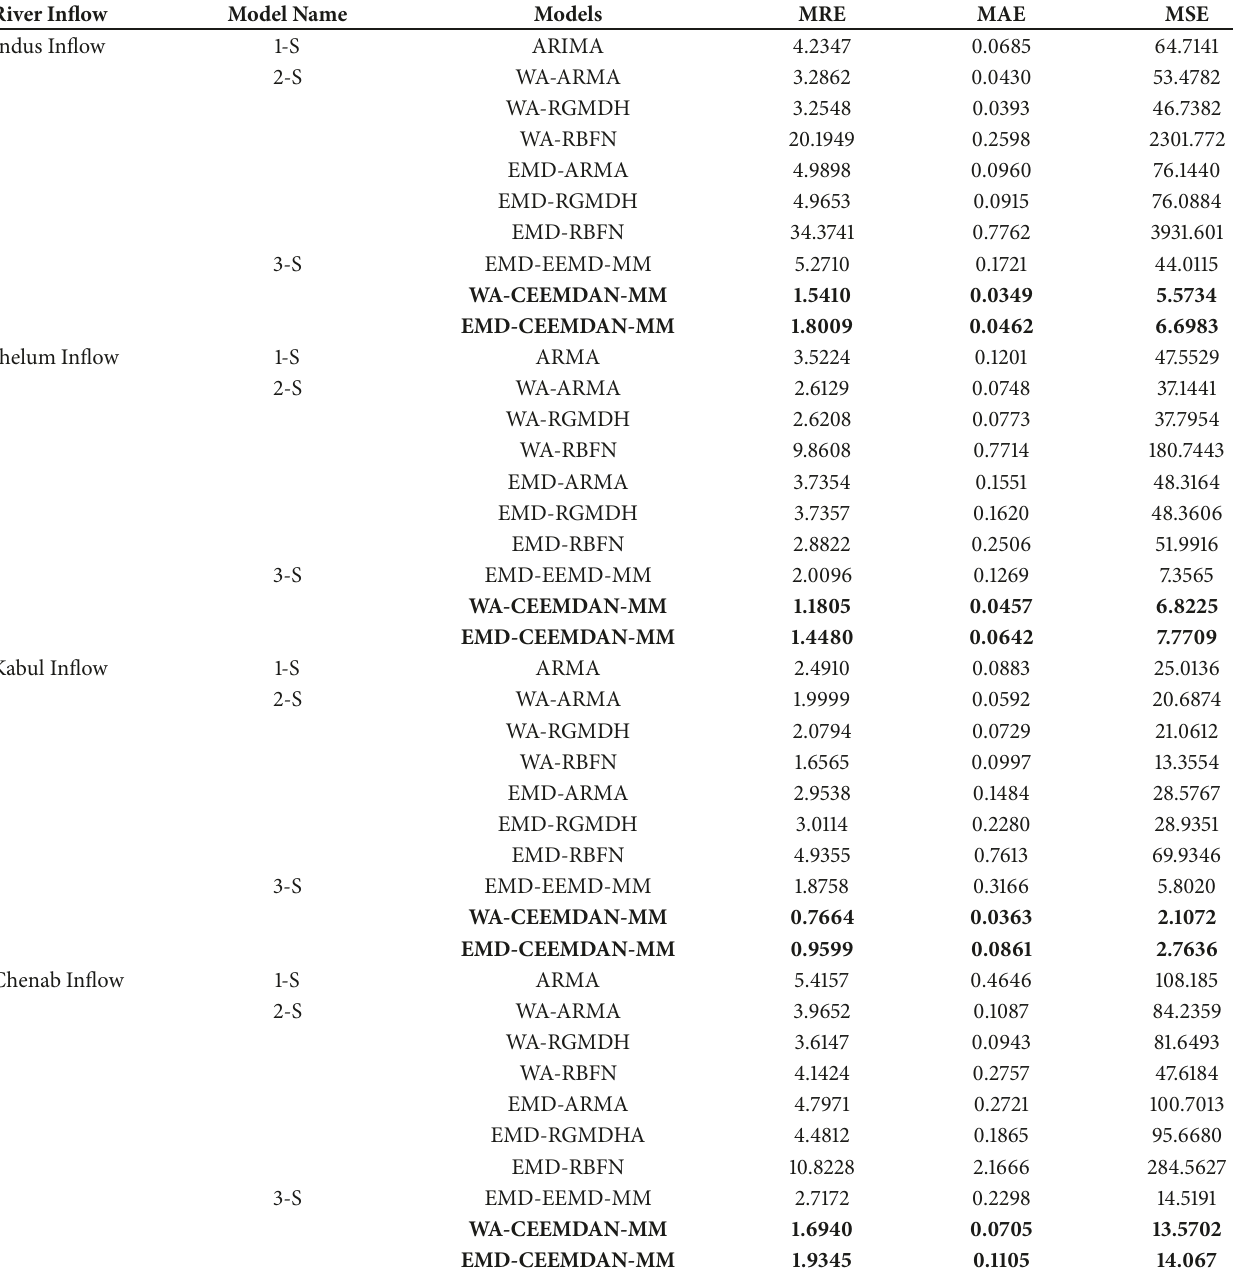
Table 3: Evaluation index of testing prediction error of proposed models (EMD-CEEMDAN-MM and WA-CEEMDAN-MM) with all selected models for all four case